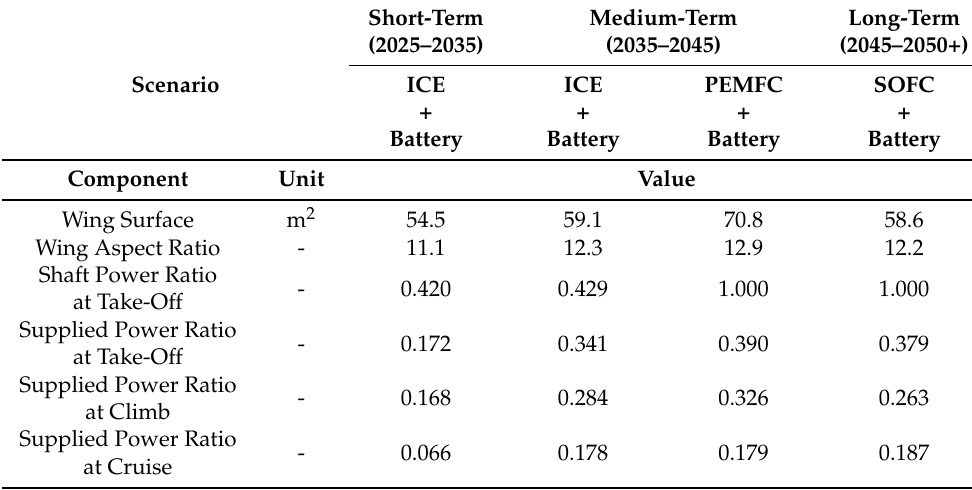
Table 8. Results of the DOE activities carried out for different